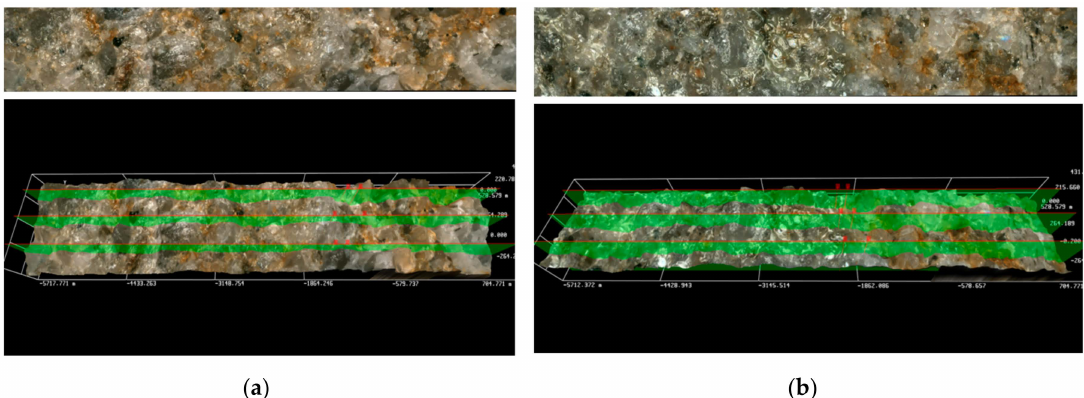
Figure 8. Results of microscopic analysis of the front surface of core No 3233 and 3229 after the damaging test S.F.: ( a ) 3a, ( b ) 3b.